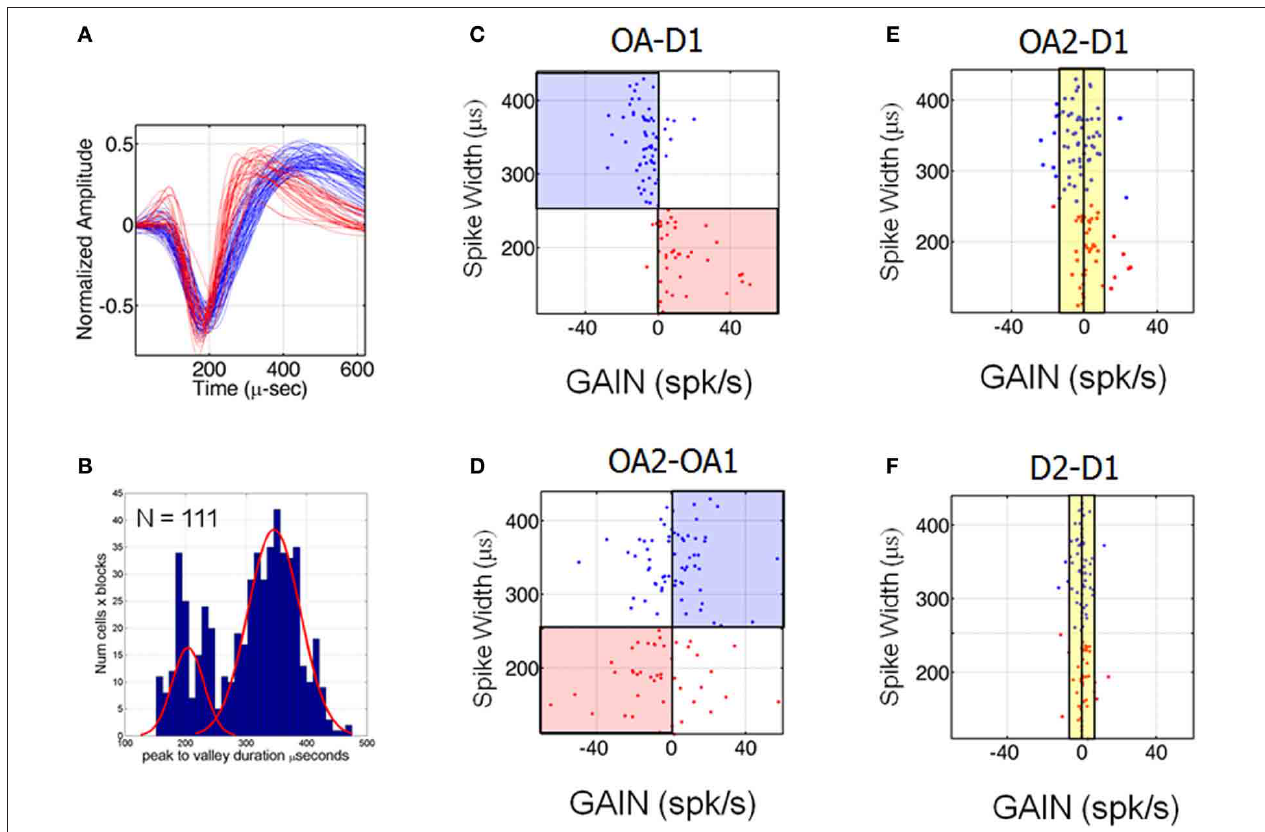
FIGURE 6 | Cells classes based on different spike widths were associated with different patterns of suppression and enhancement. (A) Average waveforms of neurons belonging to the two groups indicated by the mixture of Gaussian fit illustrated in (B) . (B) Histogram of spike widths for all trials, blocks and neurons. (C–F) Scatter plots of spike width vs. change in firing